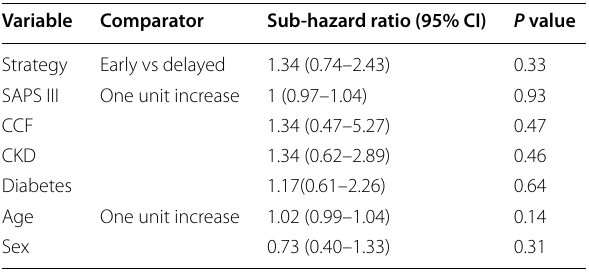
Analysis led on the 175 patients with available eGFR after